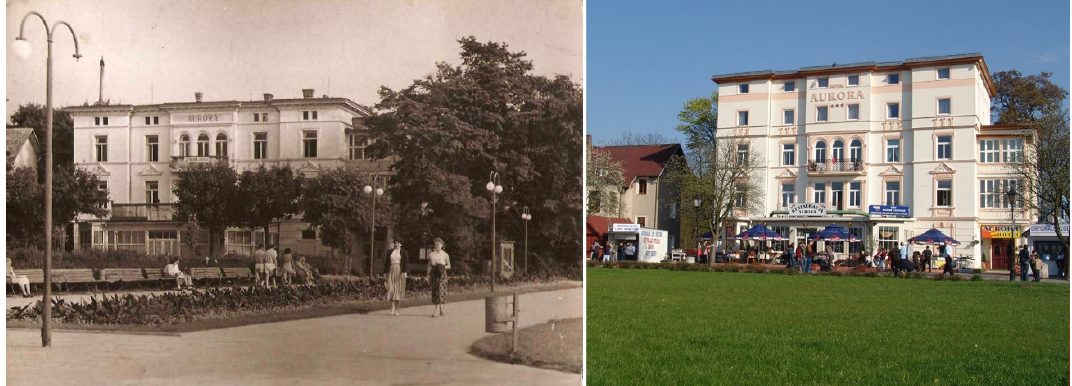
Figure 9. Aurora Hotel in Mi ę dzyzdroje, before and after changes. Source: Author’s work.